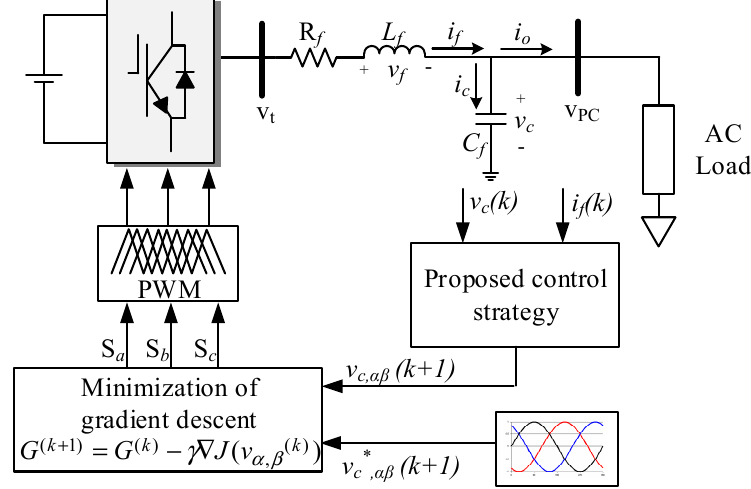
Figure 4. Space vector diagram in the αβ frame, including virtual vector states.